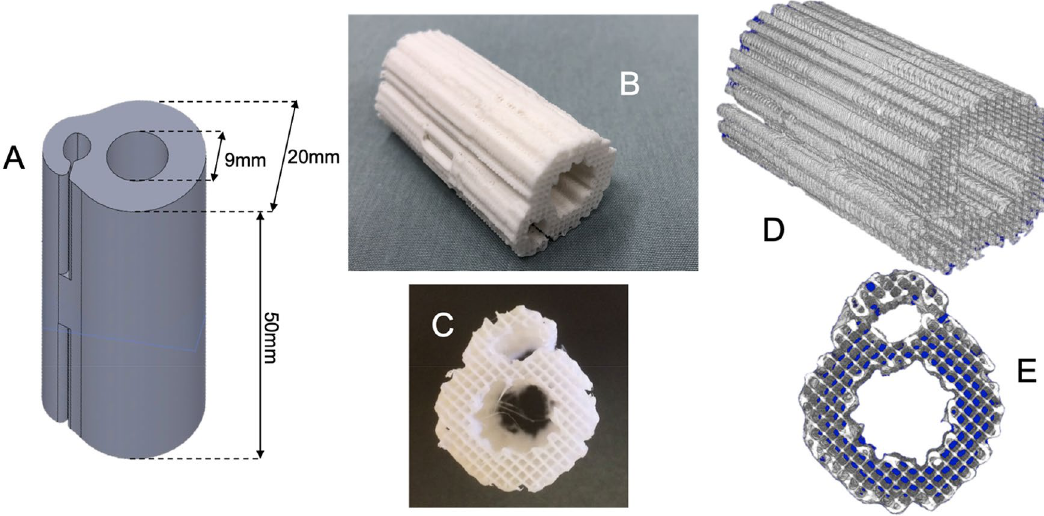
Figure 1. A 3D printed PCL/β-TCP scaffold with unique design. ( A ) Computer model of the scaffold’s geometry; ( B , C ) Photos of the scaffold after manufacturing; ( D , E ) micro-CT scaffold reconstruction (Scanco USA Inc., http:// www. scanco.